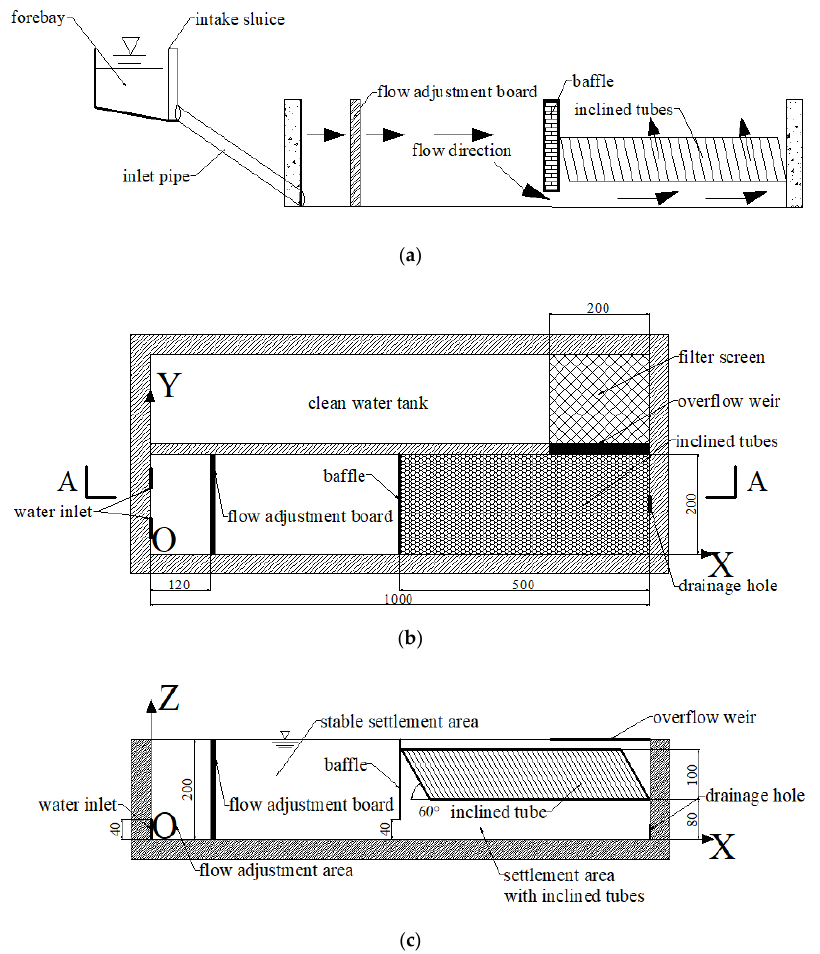
Figure 1. Schematic diagram of the inclined-tube gravity sedimentation tank: ( a ) flow direction in the inclined-tube gravity sedimentation tank, ( b ) vertical view of the inclined-tube gravity sedimentation tank, and ( c ) cross-sectional view of A-A of the inclined-tube gravity sedimentation tank (all the dimensions are in centimeters).